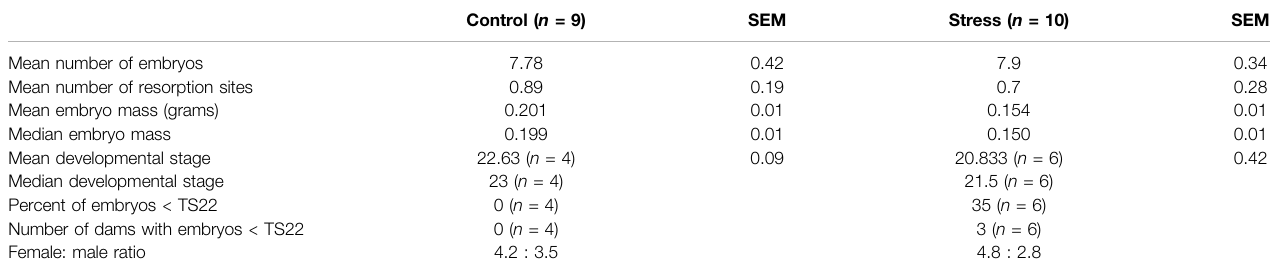
TABLE 1 | Descriptive parameters of embryo development in chronically-stressed and non-stressed (control) dams. Pregnant mice were exposed to stress for the fi rst 9 days of gestation, 4 h per day, and allowed six more days to recover before tissue collection at gestational day 15. Non-stressed pregnant mice remained in their home